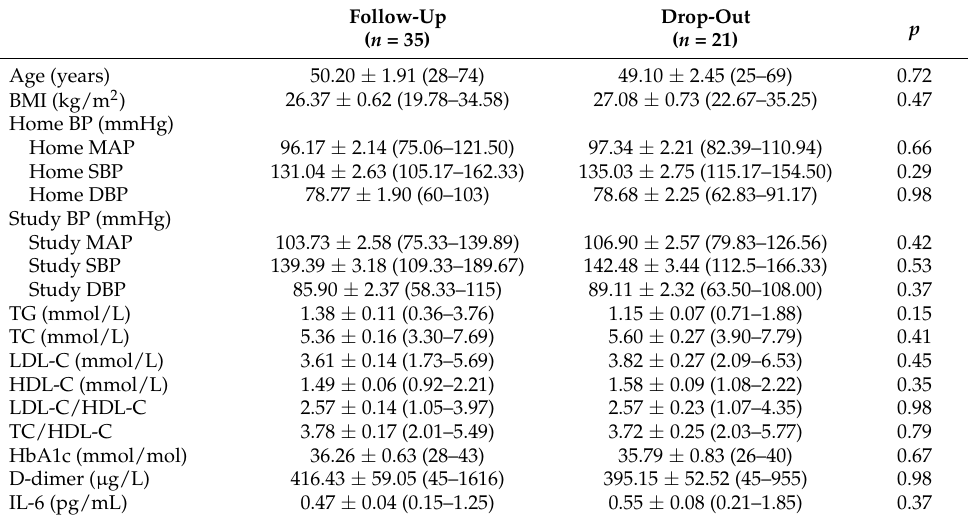
Table A1. Comparison of baseline group characteristics between participants completing follow-up assessment and drop-out participants.